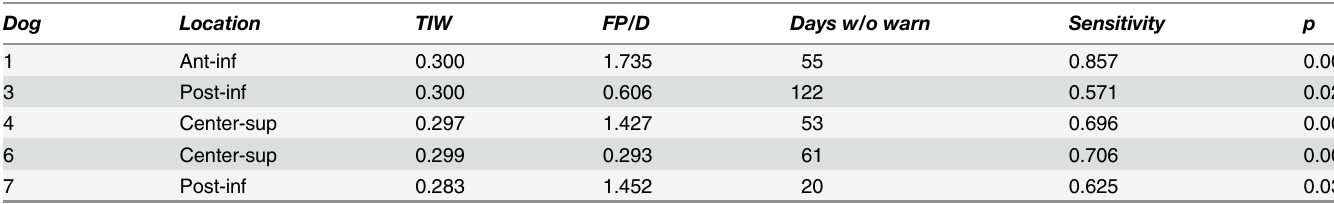
Lead seizure sensitivity at 30% TIW with correlation features improves if the classi fi er is restricted to speci fi c bilateral electrode pairs, suggesting the iEEG preictal signature is not homogeneously distributed across the brain.